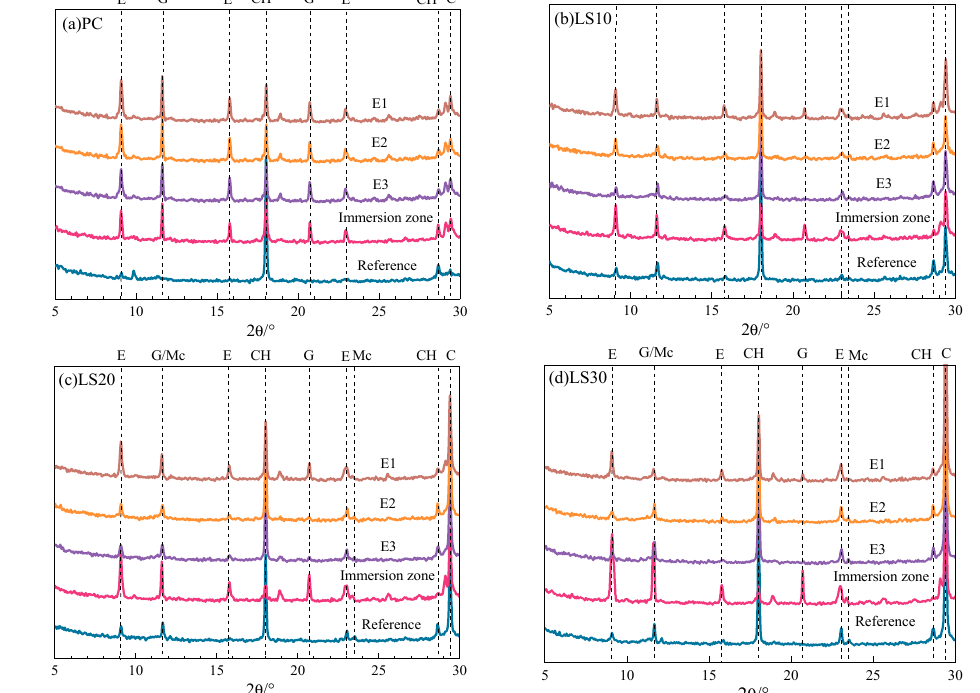
Figure 7. XRD pattern of specimens with different limestone content after partially immersed specimens for 80 days. (E—ettringite; G—gypsum; Mc—monocarboaluminate; CH—portlandite).